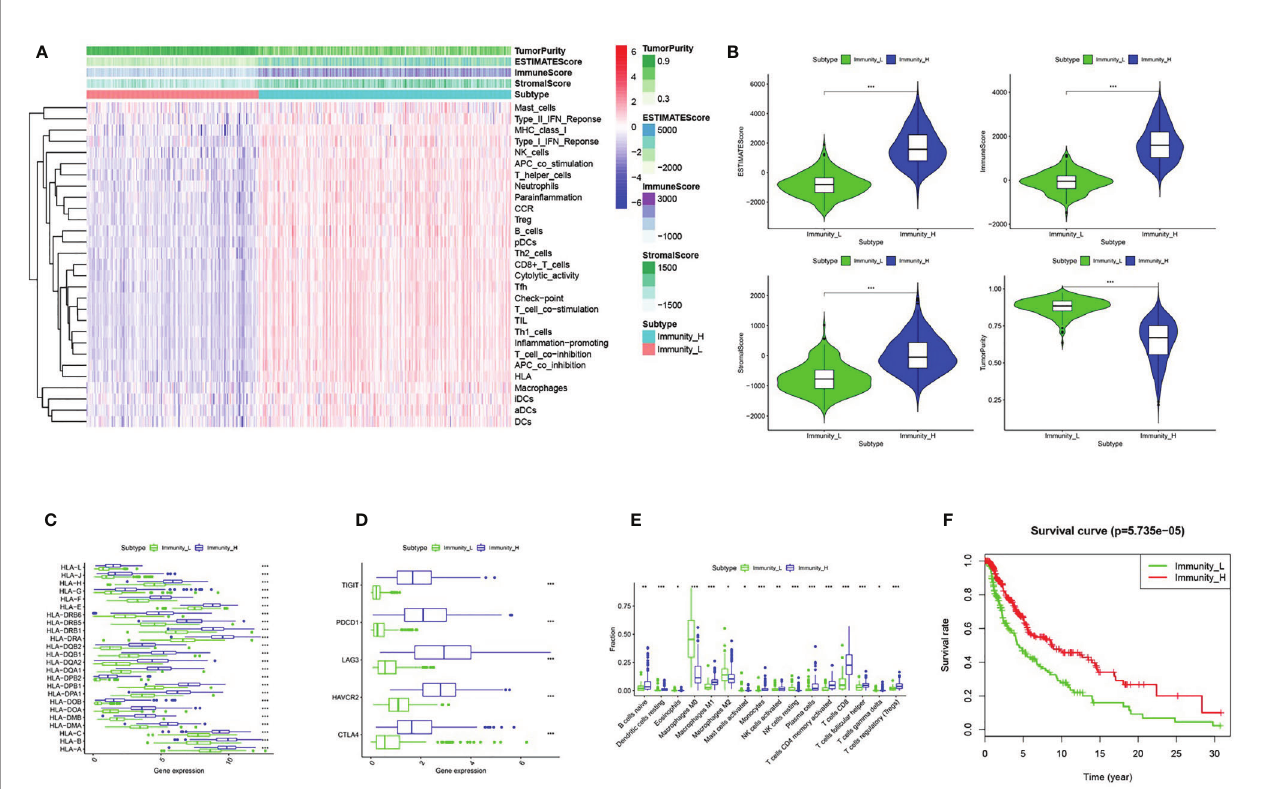
FIGURE 1 | Grouping and veri fi cation of melanoma. (A) The immune cells were highly expressed in the high immune cell in fi ltration group (Immunity_H), and the low expression in the low immune cell in fi ltration group (Immunity_L). The Tumor Purity, ESTIMATE Score, Immune Score and Stromal Score were illustrated along with the grouping information. (B) There is a statistical difference of the Tumor Purity, ESTIMATE Score, Immune Score and Stromal Score between the high immune cell in fi ltration cluster and the low immune cell in fi ltration cluster (C, D) The expression of HLA family genes, TIGIT, PDCD1, LAG3, HAVCR2, and CTLA4 in the high immune cell in fi ltration cluster (red) were signi fi cantly higher than that of the low immune cell in fi ltration cluster (green) (E) The statistical graph shows the difference in the proportion of each immune cell between the high immune cell in fi ltration cluster (red) and the low immune cell in fi ltration cluster (green). (F) Survival difference between high immune cell in fi ltration cluster and low immune cell in fi ltration cluster. * P < 0.05, ** P < 0.01, *** P <